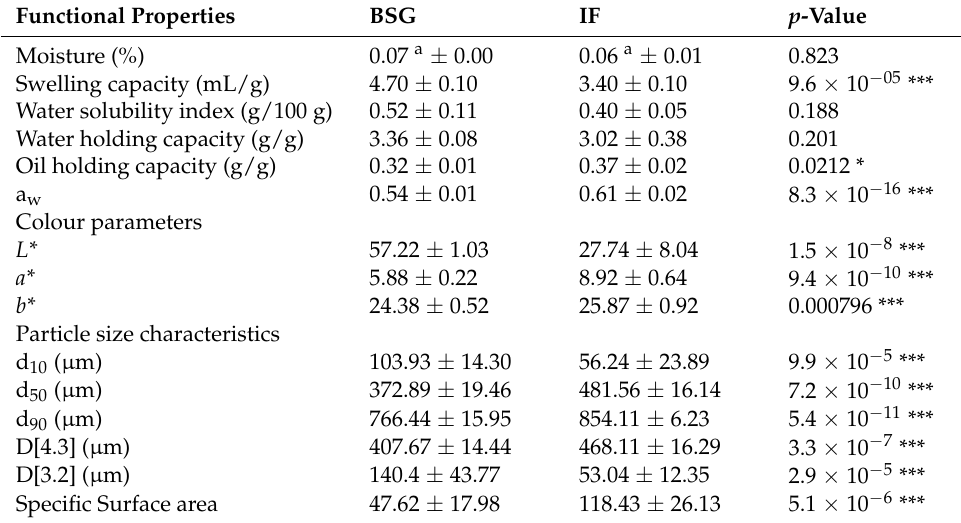
Table 1. Physicochemical characteristics of upcycled brewer’s spent grain (BSG) and insect flour (IF). Values show mean ± standard deviation, n =